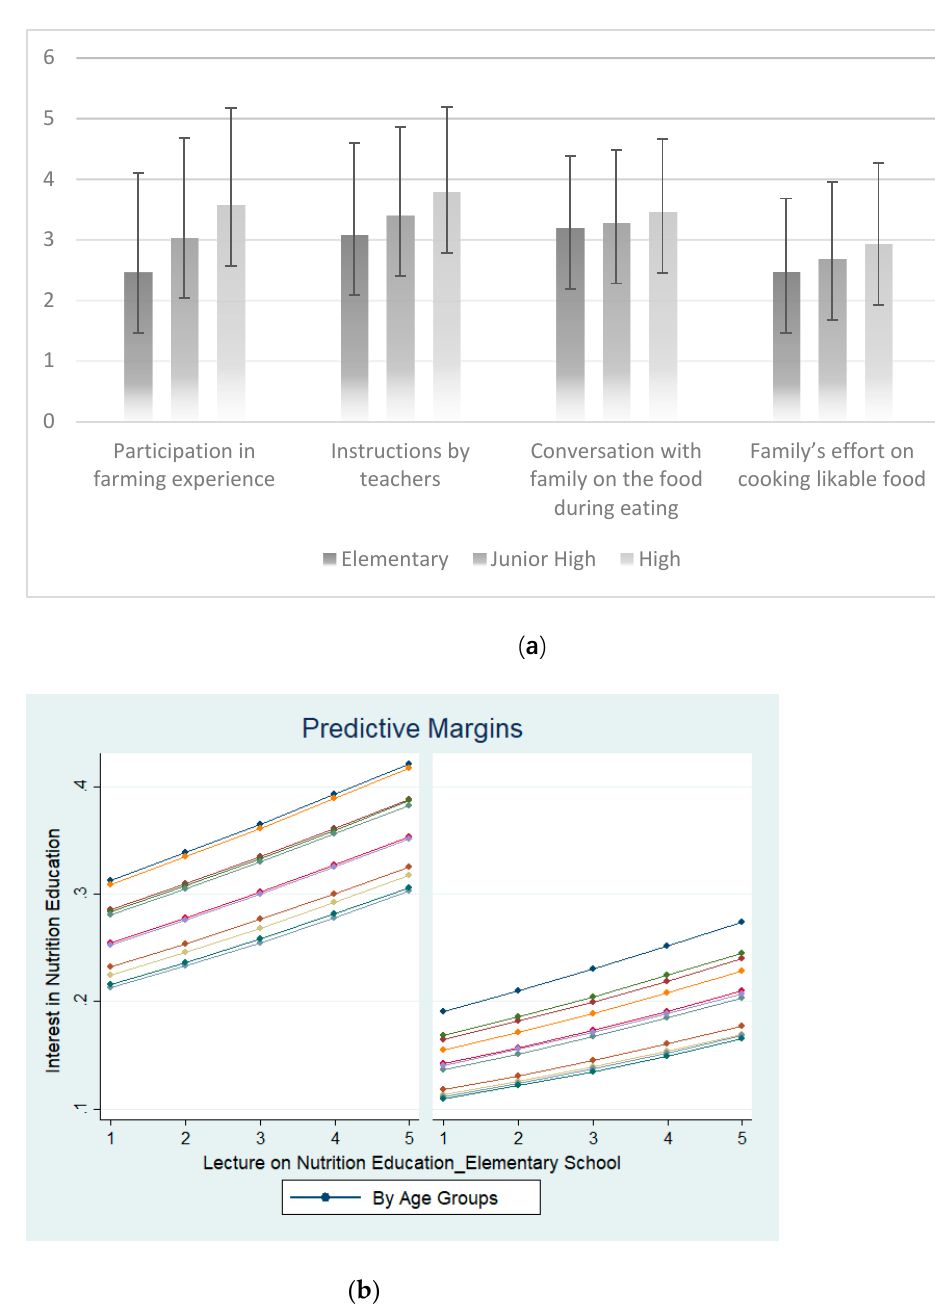
Figure 1. ( a ) Effect of nutrition education instruction by instructors at elementary school on interest in nutrition education, by gender and by age groups. ( b ) Effect of nutrition education instruction by instructors at elementary school on interest in nutrition education, by gender and by age groups. Left shows the results of male respondents and right shows the results of female respondents. The 1–5 scales reflect the degree of the respondents’ experiences. 1 = strongly agree, 2 = agree a little, 3 = neither agree nor disagree, 4 = disagree a little, and 5 = strongly disagree.